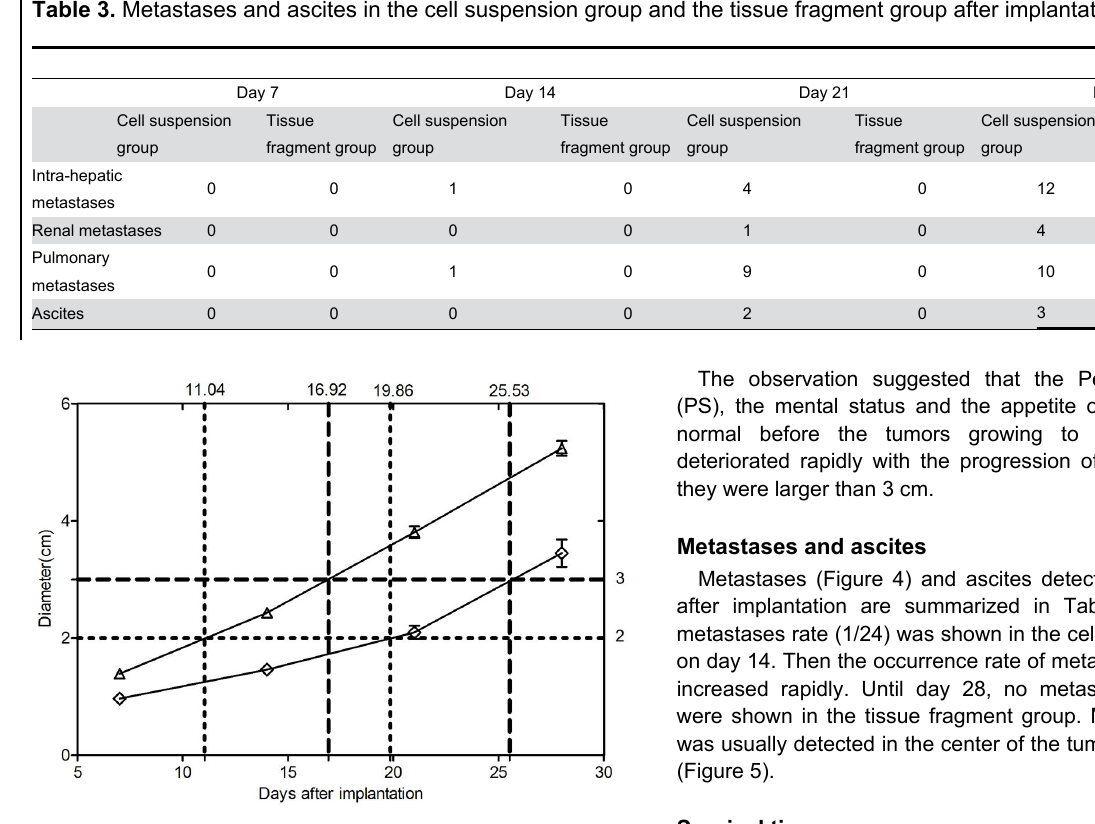
respectively by cell suspension method, and 19.9 days and 25.5 days, respectively by tissue fragment method.